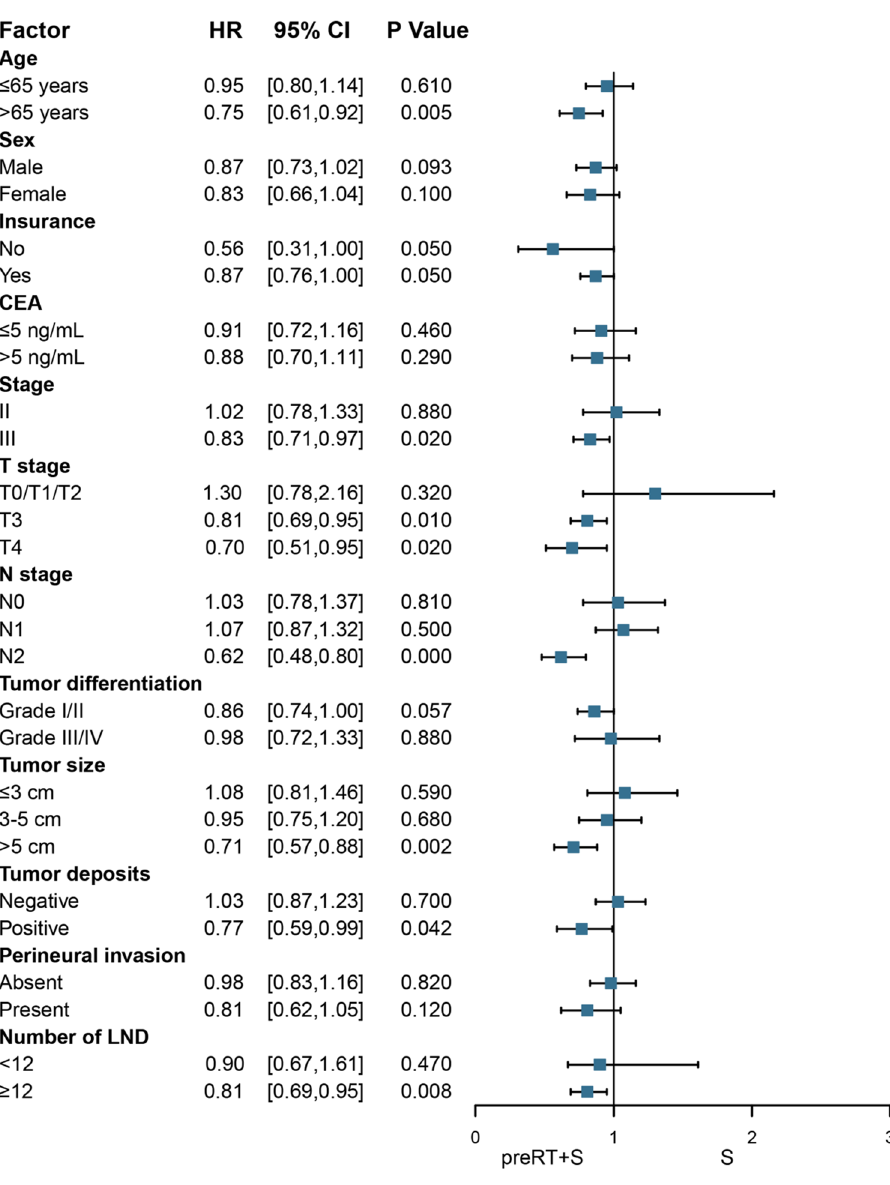
Figure 2. Subgroup analysis of OS stratified by risk factor. CEA carcinoembryonic antigen, LND dissected lymph nodes, preRT preoperative radiotherapy, S surgery, HR hazard ratio, CI confidence